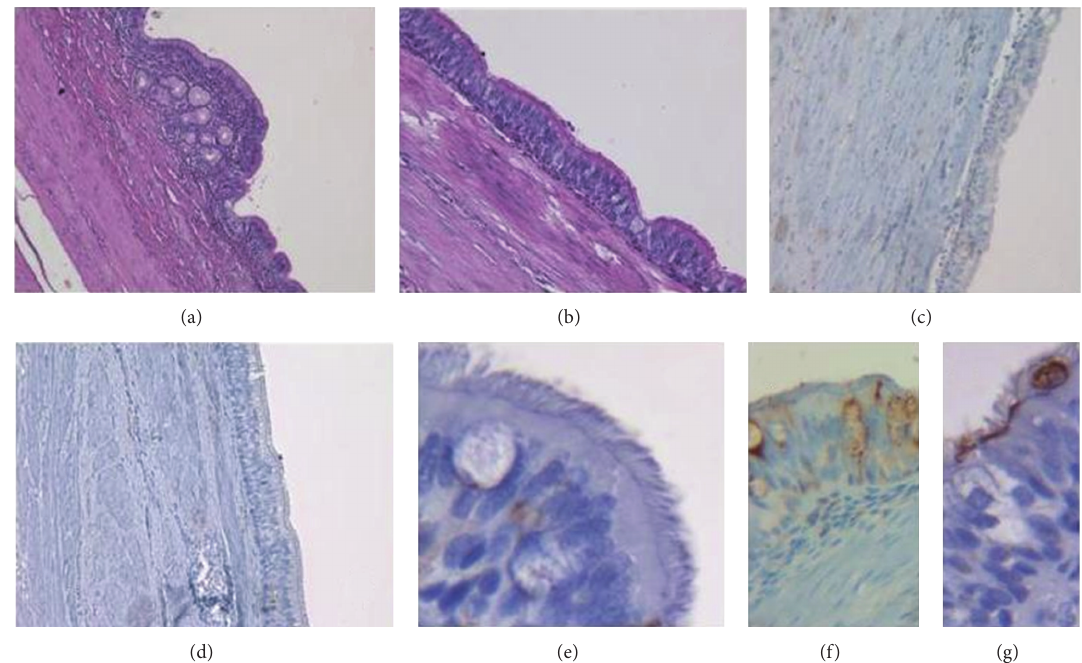
Figure 3: Cyst’s wall was focally lined by gastric foveolar epithelium with cardial glands ((a) H/E, 200x), while most of the cyst was lined by a pseudostratified epithelium with ciliated cells ((b) H/E, 200x). Pseudostratified columnar ciliated epithelium was negative for CK20 ((c) 200x), TTF-1 ((d) 200x), and MUC5AC ((e) 400x) while expressed CEA ((f) 200x) and MUC1 ((g)